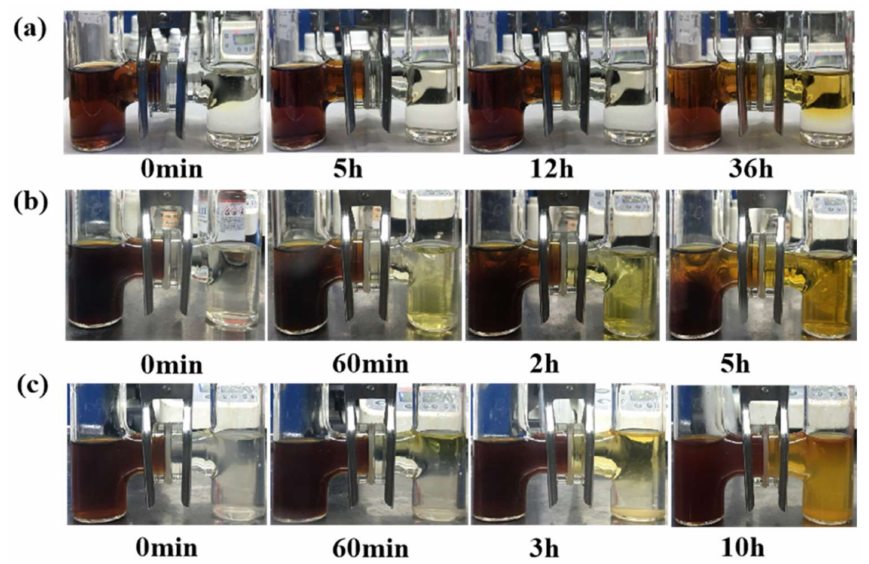
Figure 3. The sieving effect experiments with different separators: ( a ) ATG-DMTZ-COF/PP separator. ( b ) blank PP separator. ( c ) Super P/PP